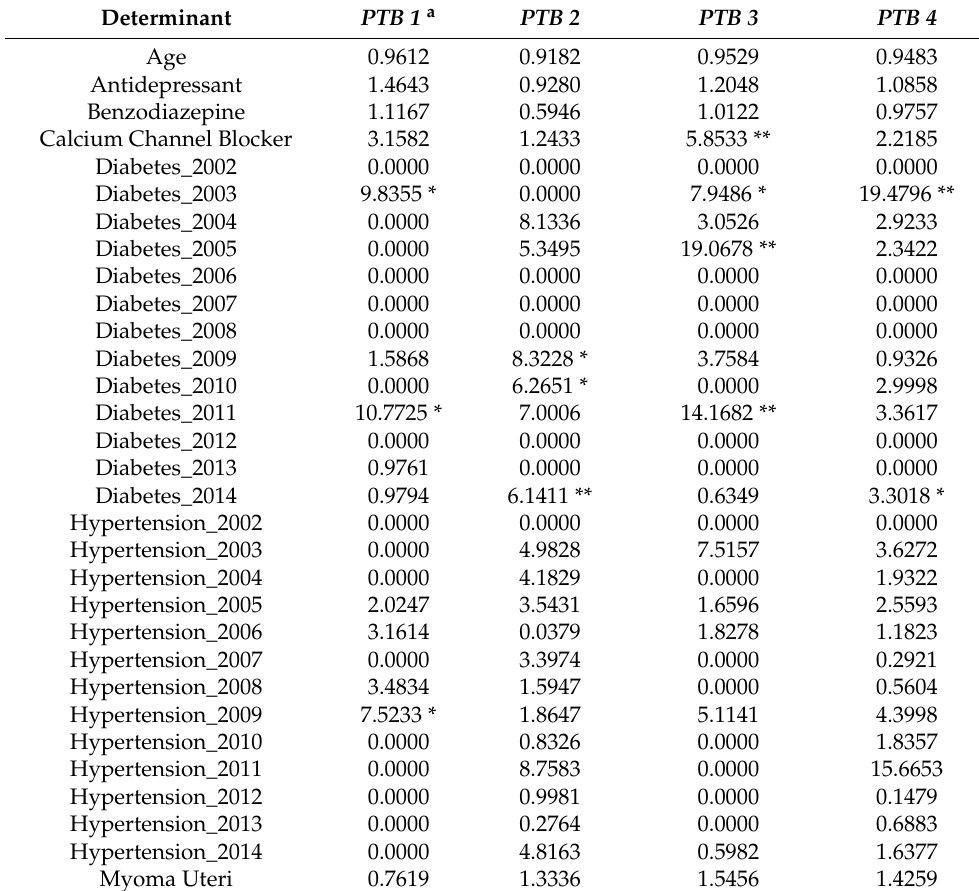
Table 3. Logistic Regression Results for Each Type of Preterm Birth: Crohn